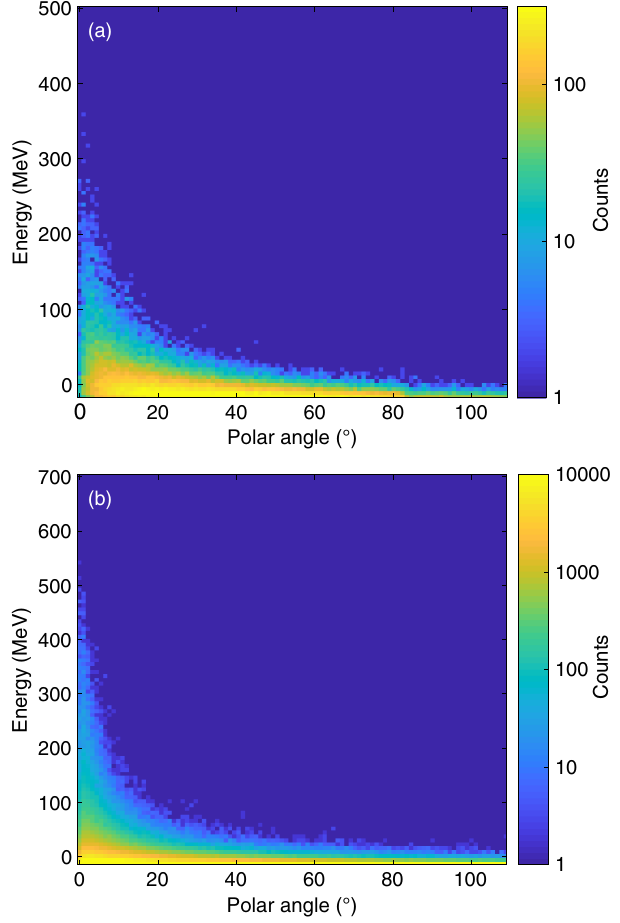
FIG. 14. Polar angular distribution as a function of the energy for the electrons (a) and photons (b) produced after the inter- action. On the x axis, angles close to 0° (180°) mean that the particles are moving forward (backward) with respect to the incoming electron